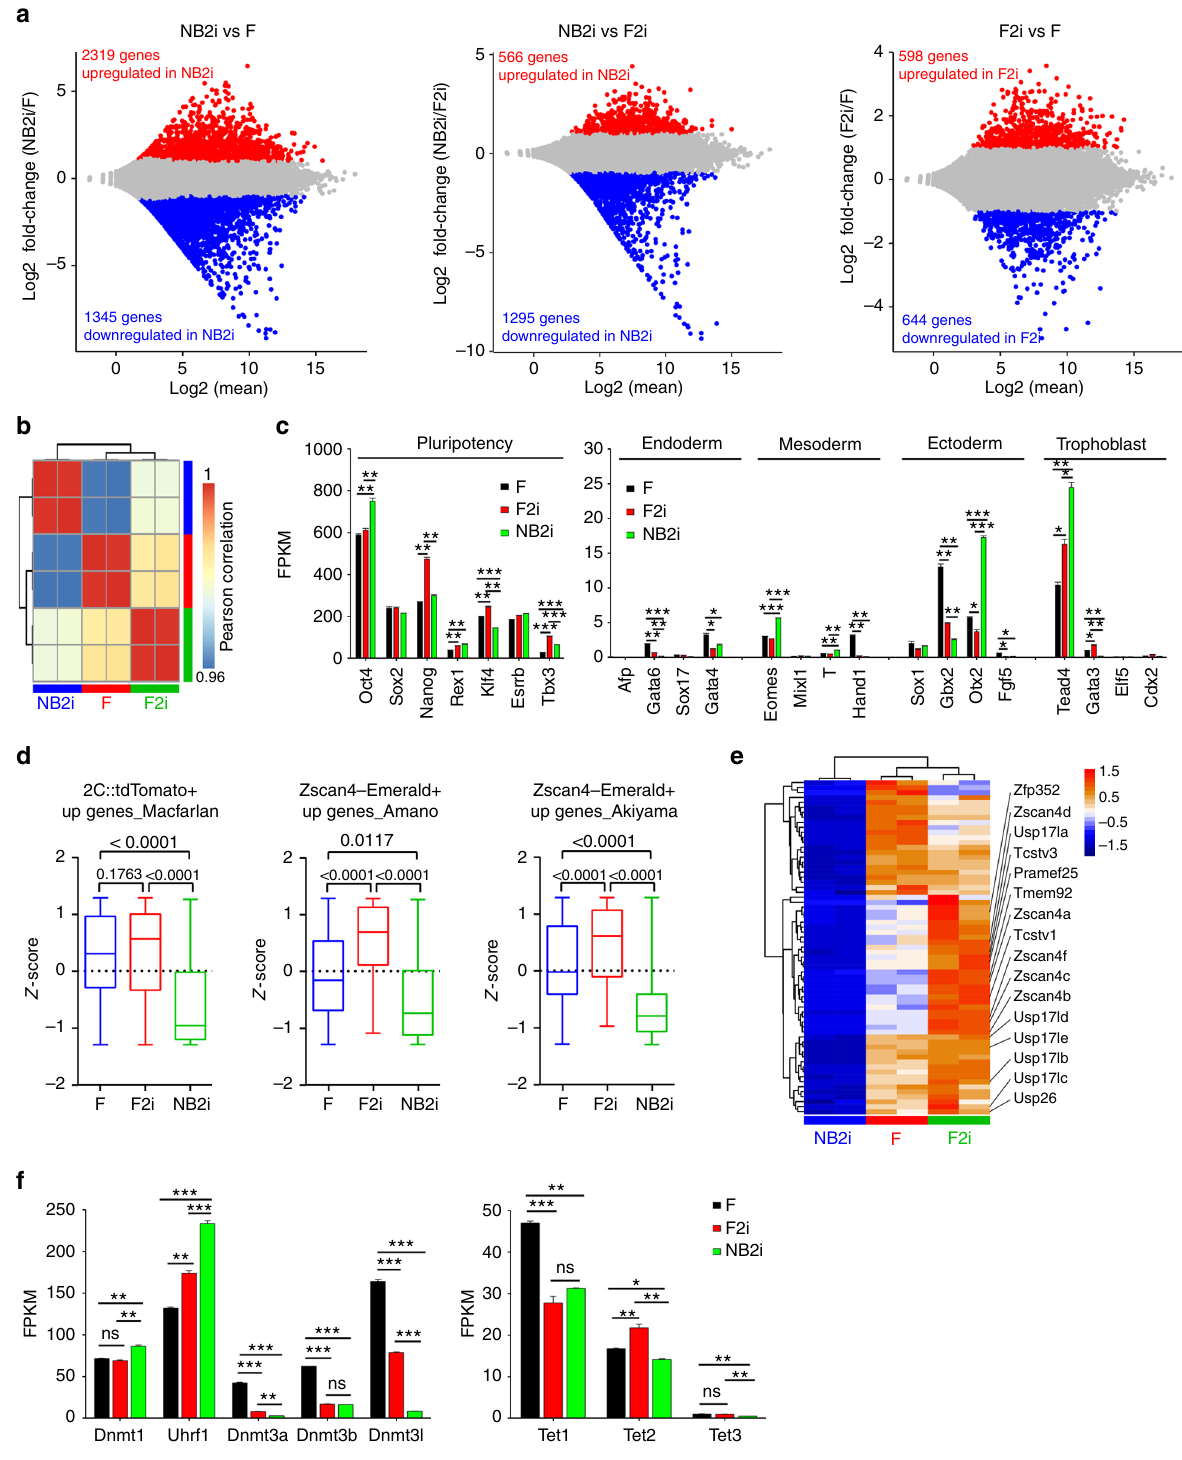
Fig. 7 Global gene expression pro fi le in ESCs cultured with feeders and/or 2i. a Pairwise comparisons ( P adj < 0.05, ≥ 2-fold expression levels) of ESCs cultured in N2B27 + 2i (NB2i) vs serum + feeder (F), NB2i vs serum + feeder (F2i) and F2i vs F to reveal non-redundant, signi fi cant changes in gene expression. Red dots represent signi fi cantly upregulated genes, blue dots downregulated genes, and gray dots represent genes that are not signi fi cantly changed. b The Pearson ’ s correlation coef fi cient to estimate the relationships between samples at the whole transcriptome level. c Expression levels (FPKMs) of pluripotency and lineage marker genes in ESCs under three culture conditions. d Z-scores of several lists of 2C genes. Lists used here are based on those of Fig. 4c. e Heatmap showing expression of representative 2C genes. f Expression levels (FPKMs) of multiple genes involved in DNA (de) methylation in ESCs under three culture conditions. * P < 0.05, ** P < 0.01, *** P < 0.001, ns not signi fi cant ( P > 0.05). ANOVA with Fisher ’ s protected least- signi fi cant difference (PLSD) was used for the statistical analysis